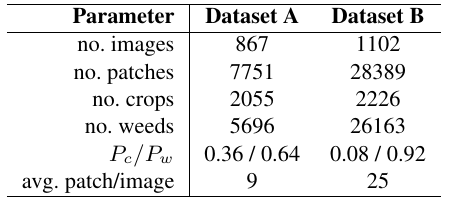
Table 1. Information about the